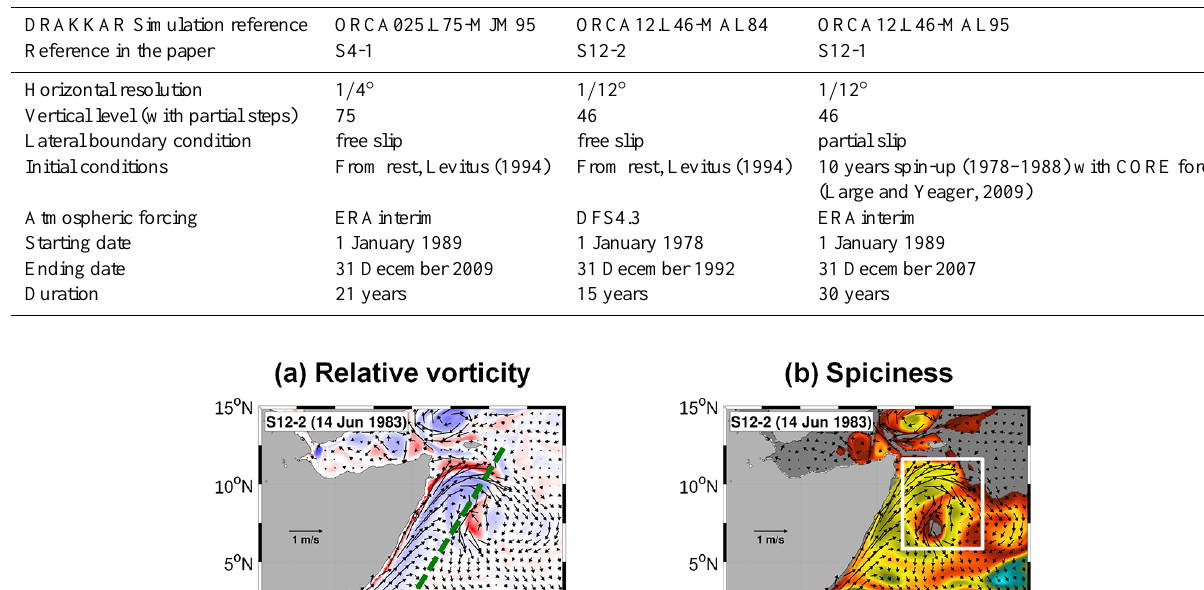
Table 1. Specificities of the global model simulations. Only differences between runs are reported. The full model characteristics are de- scribed in Drakkar technical reports by Lecointre et al. (2011a, b) and are summarized in DRAKKAR-Group et al. (2014). Model variables are stored every 5 days as 5-day means.